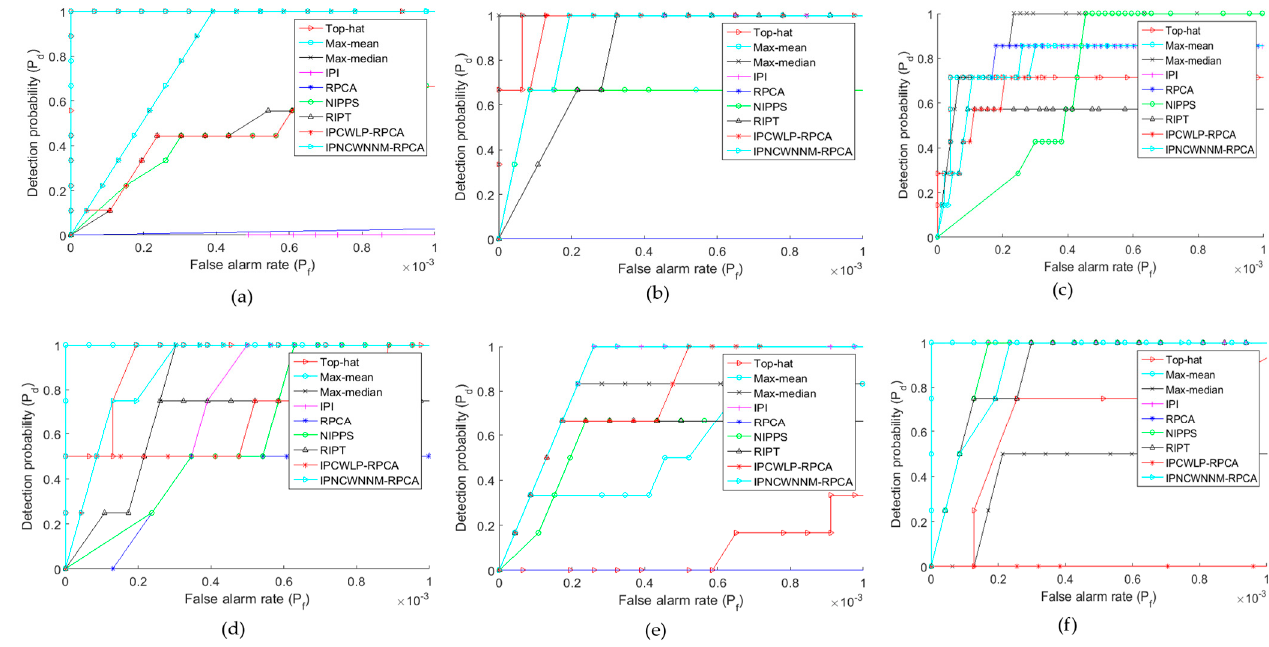
Figure 7. ( a – f ) are the Receiver operating characteristic curves (ROCs) for the six image sequences from Figure 5a.